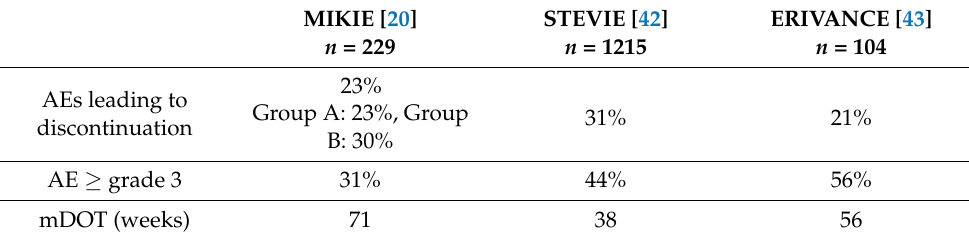
Table 2. Discontinuation rates in three vismodegib studies using on-off treatment schedules (MIKIE) or continuous dosing (STEVIE,